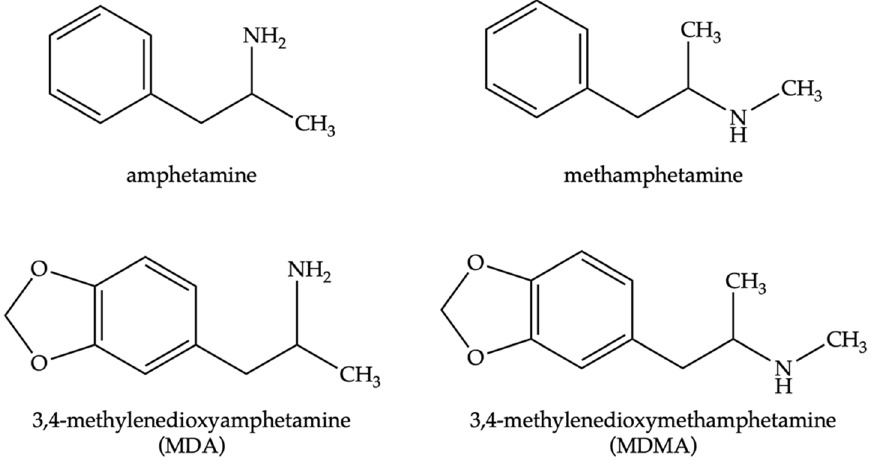
Figure 1. Structures of members of the amphetamine-type stimulants (ATS) class of amphetamine, methamphetamine, 3,4-methylenedioxyamphetamine (MDA), and 3,4-methylenedioxymethamphetamine (MDMA).